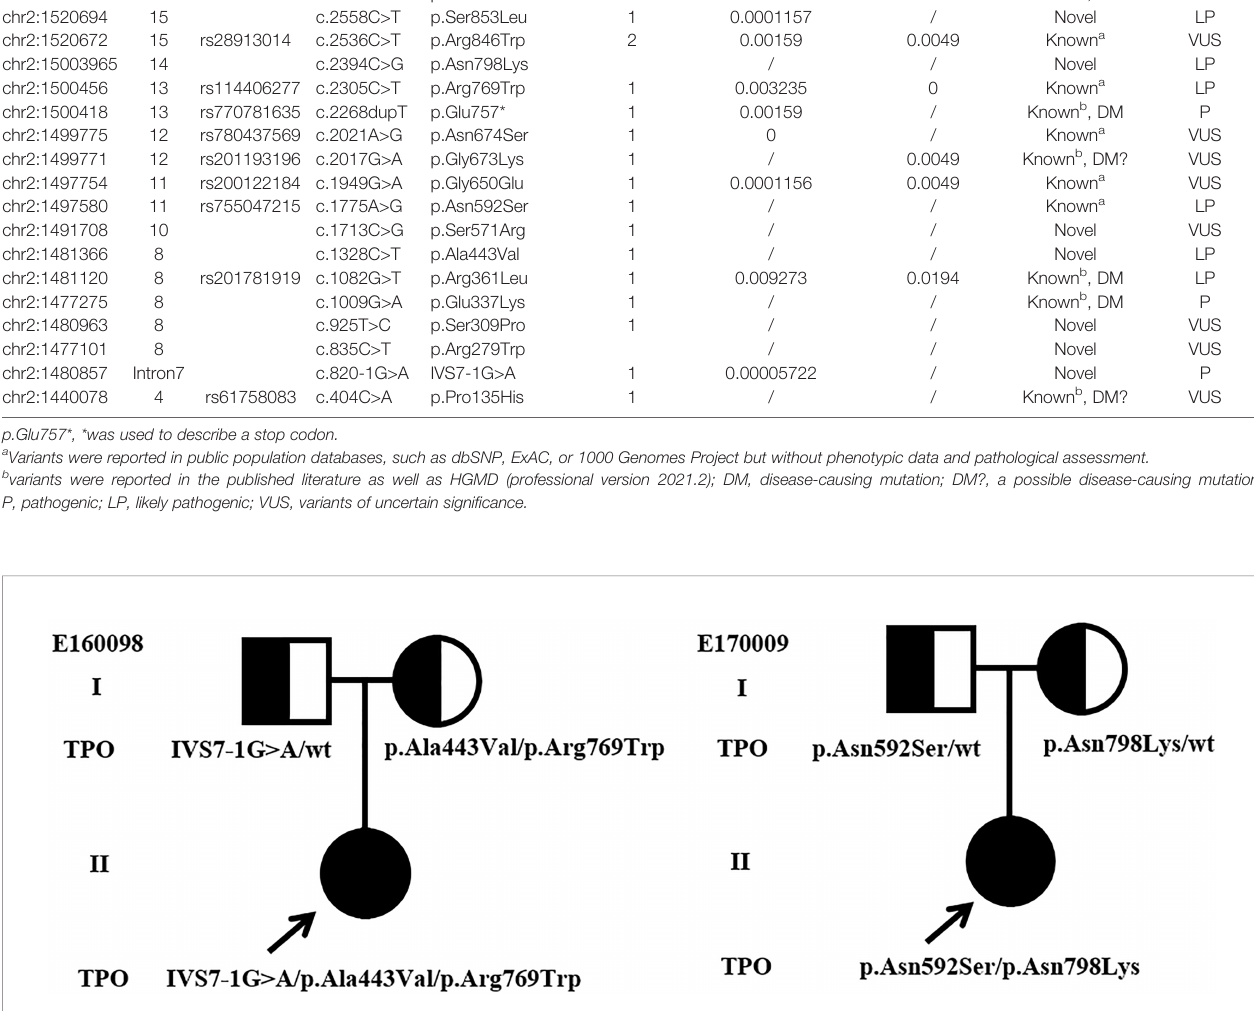
Supplementary Figure 1 ). The comparison between predicted tertiary structures of wt and mutant proteins was performed.